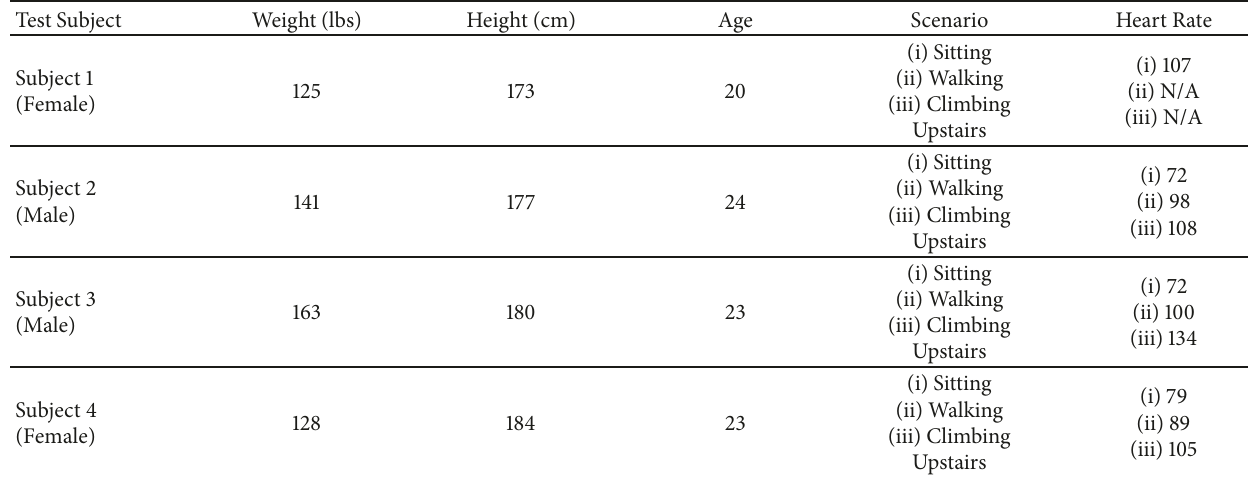
Figure 9: ECG signals for sitting, walking, and climbing upstairs for test subject 1. Table 5: Test subject